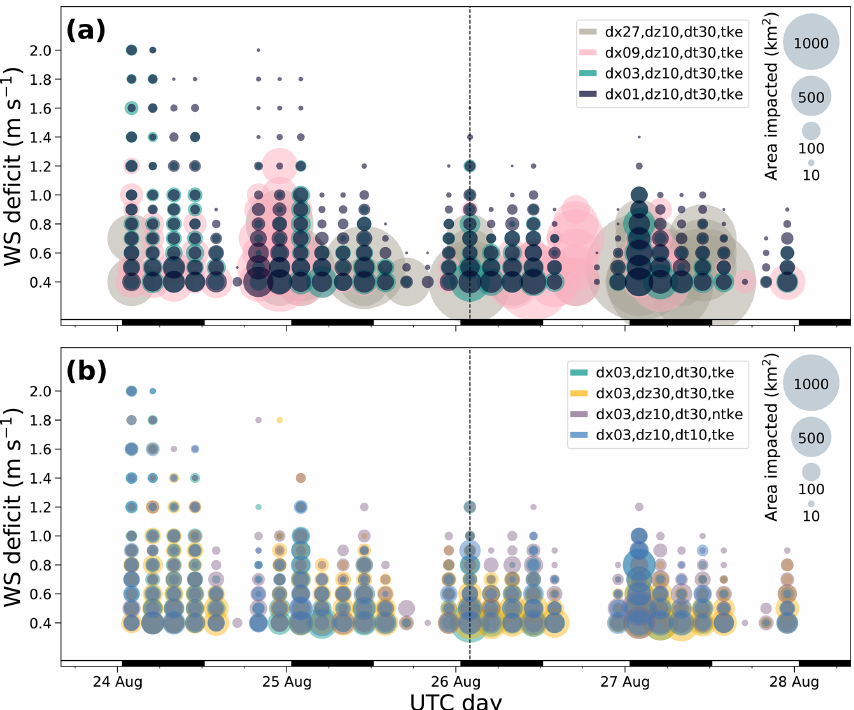
Figure 7. Time series of area impacted by the wake-induced, 80m wind speed deficits as predicted by the tested simulations, plotted every 3h throughout the period. The size of the dots represents the spatial coverage of their respective magnitude of impact (scale denoted in top right), with each dot colored based on its configuration. Areas of impact were calculated for deficits every 0.1ms − 1 between 0.4 and 1.0ms − 1 , then every 0.2 until 2.0ms − 1 . The configurations are divided into groups that (a) vary horizontal resolution and (b) hold horizontal resolution constant and vary other model settings. The time chosen for the qualitative analysis (26 August 02:00UTC) in Fig. 6 is denoted by the black dashed line. Black and white bar at bottom denotes post-sunrise (white) and post-sunset (black) times.